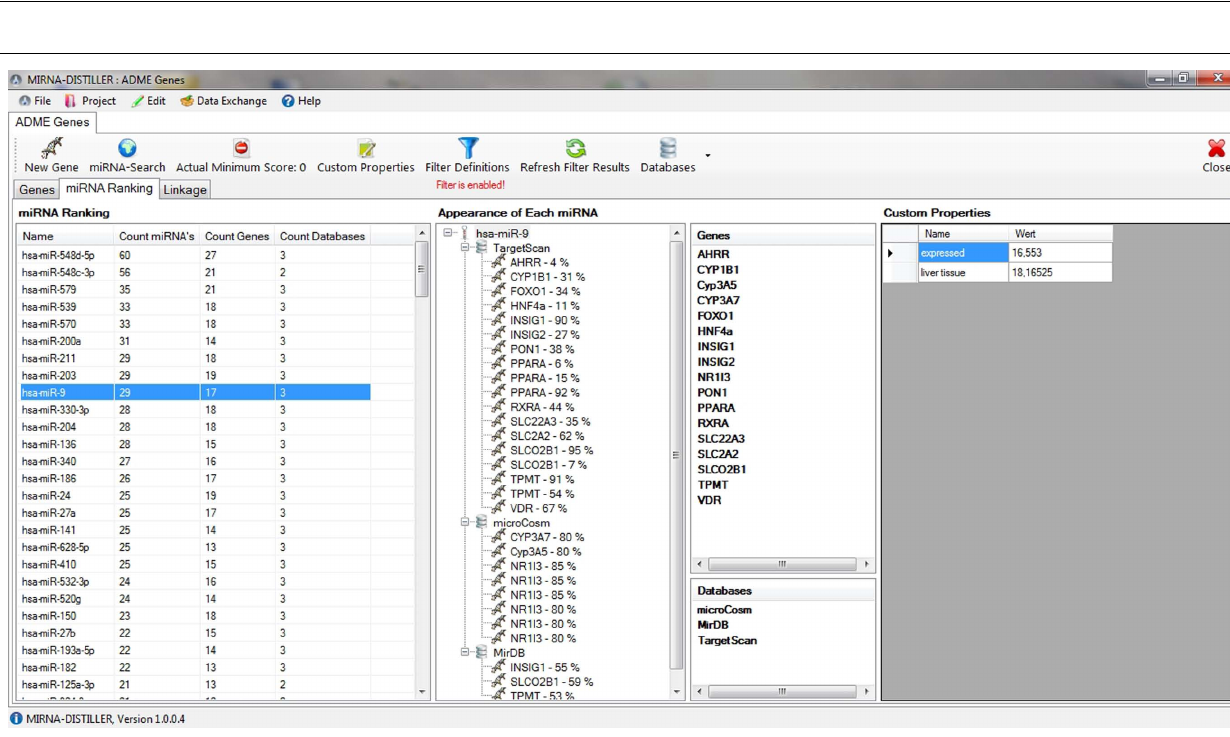
FIGURE 2 | Main interface. The left window lists the genes of interest that have been entered before, the middle window contains the predicted miRNAs with corresponding scores for each selected database and the intersection list, and the right window displays the selected intersection graphically.